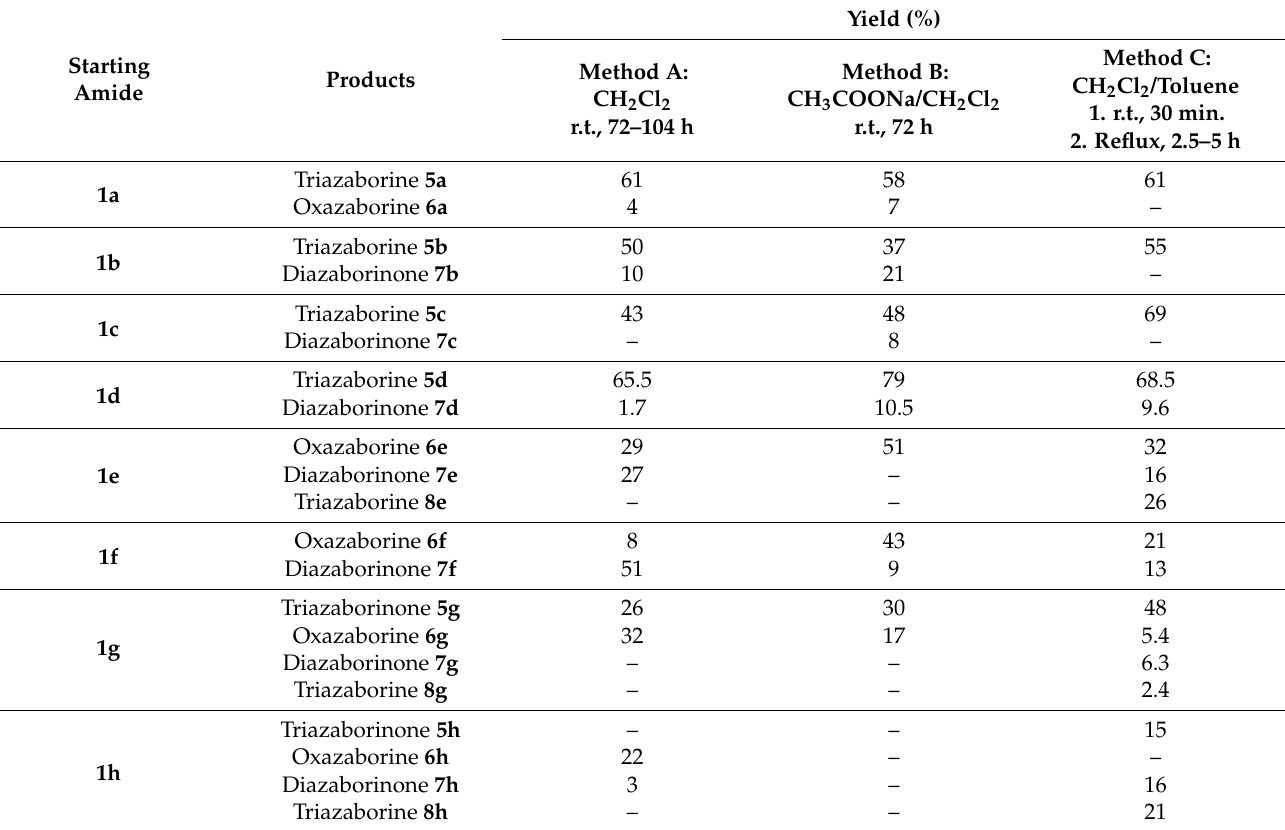
Table 1. Yields of boron compounds prepared under three different reaction conditions.